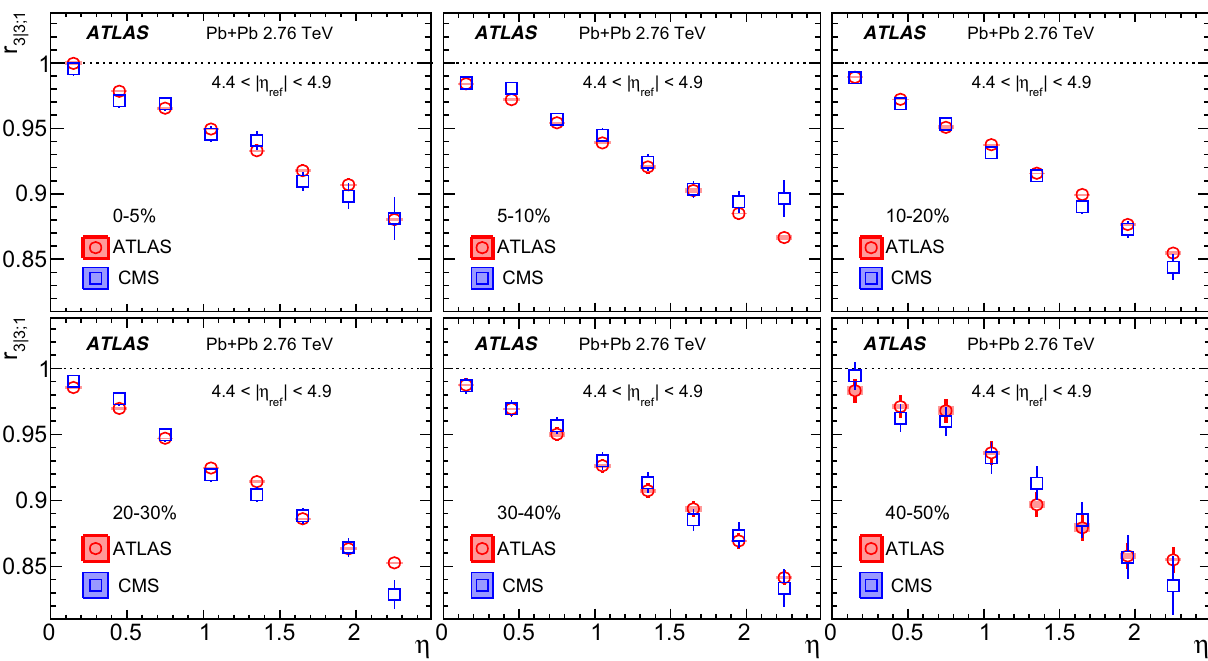
Fig. 26 The values of r 3 | 3 ; 1 measured by ATLAS and by CMS [19] for Pb+Pb collisions at 2.76 TeV, for the same reference pseudorapidity 4 . 4 < | η ref | < 4 . 9